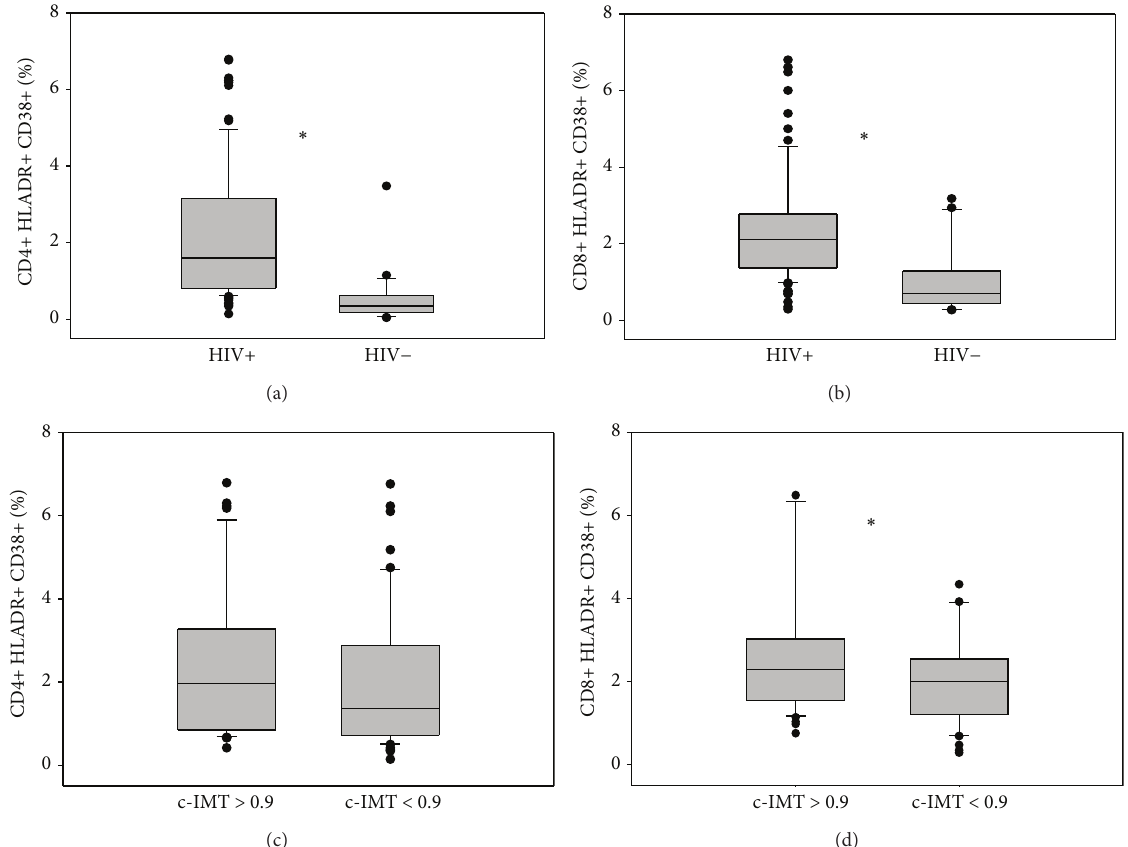
Figure 1: CD4+ (a) and CD8+ (b) immune activation in HIV-infected subjects compared with HIV-negative controls. CD4+ (c) and CD8+ (d) immune activation in HIV-infected subjects according to c-IMT. Values are expressed as percentage. Horizontal bars represent median. Upper and lower whisker mean third quartile +1.5 (interquartile range (IQR)) and first quartile-1.5(IQR). ∗ It represents a 𝑃 value <